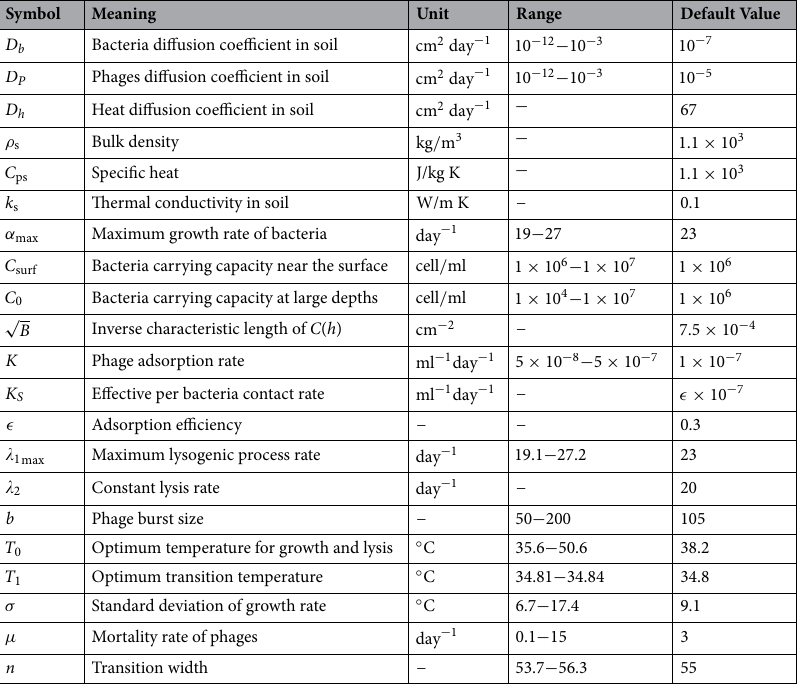
Table 1. Parameters used in the model along with their units and